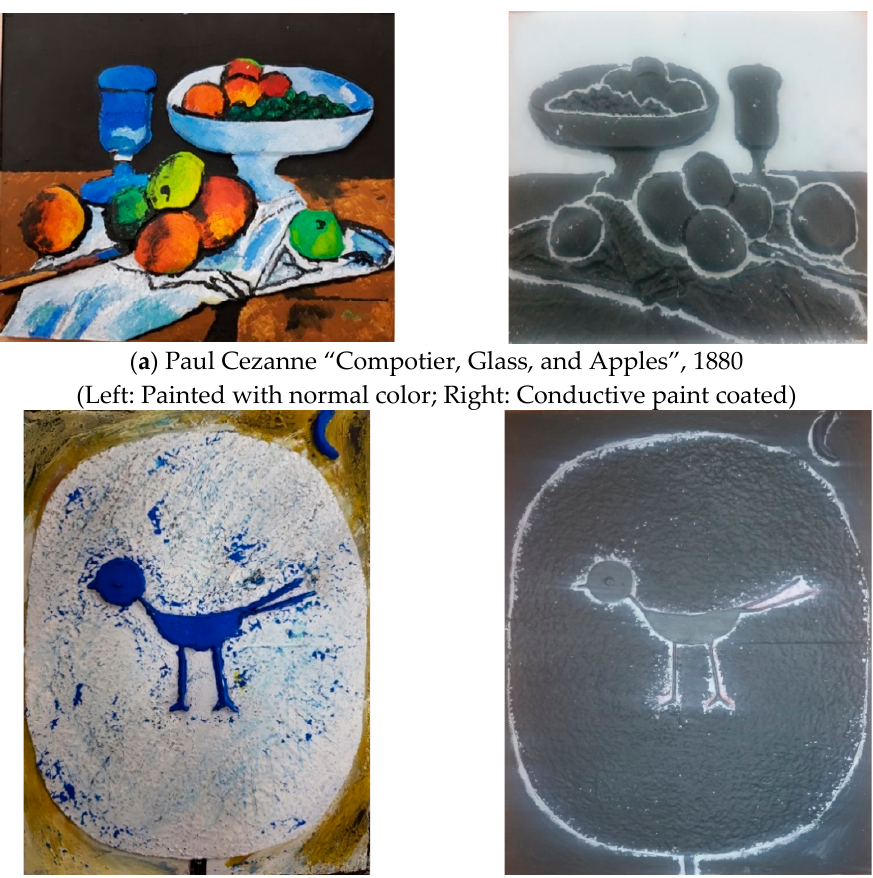
Figure 1. Tactile 3-D printed reproductions in 2.5D model of works (courtesy of Luis Cavazos